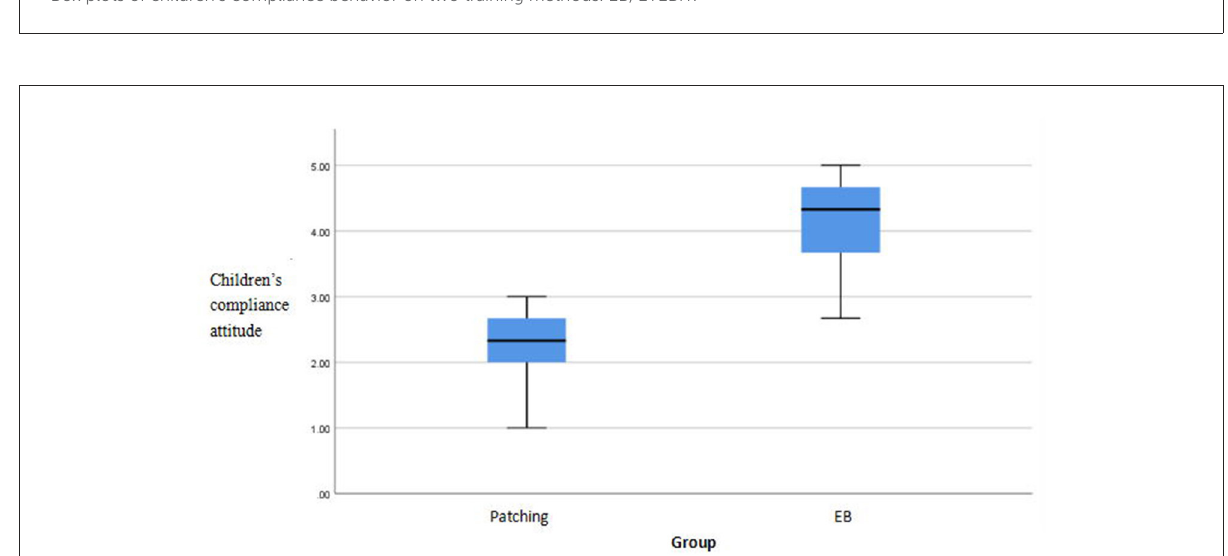
FIGURE5 Box plots of children’s compliance attitude on two training methods. EB,